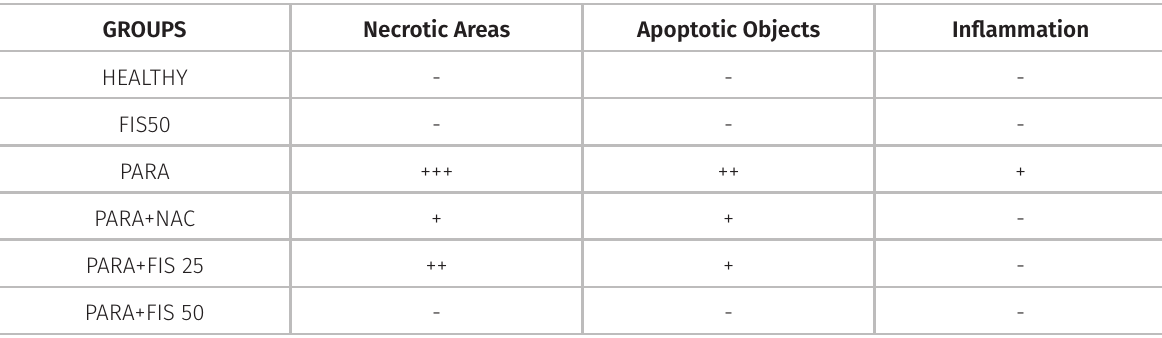
Table I. Histopathological